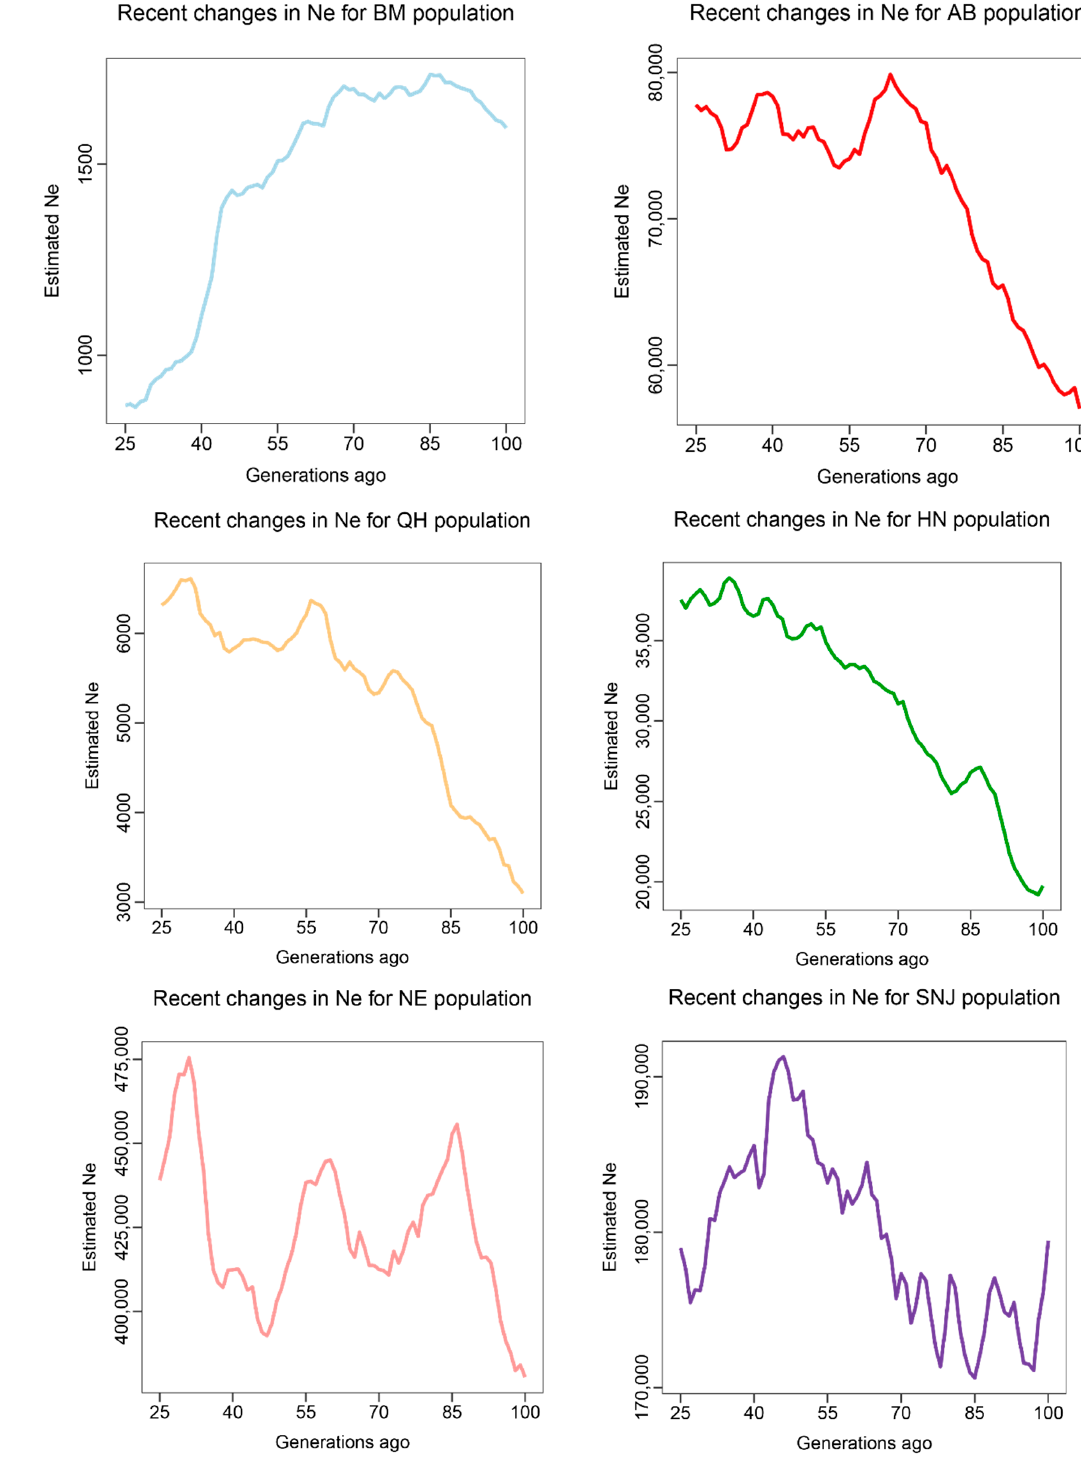
Figure 2. The trends of effective population size ( Ne ) change in the recent past inferred by software GONE for six Asian honeybee population groups (BM from Bomi, Tibet; AB from Aba prefecture, Sichuan province; QH from Qinghai province; HN form Hainan Island; NE from Liaoning, Jilin and Heilongjiang province; SNJ from Shennongjia, Hubei province).